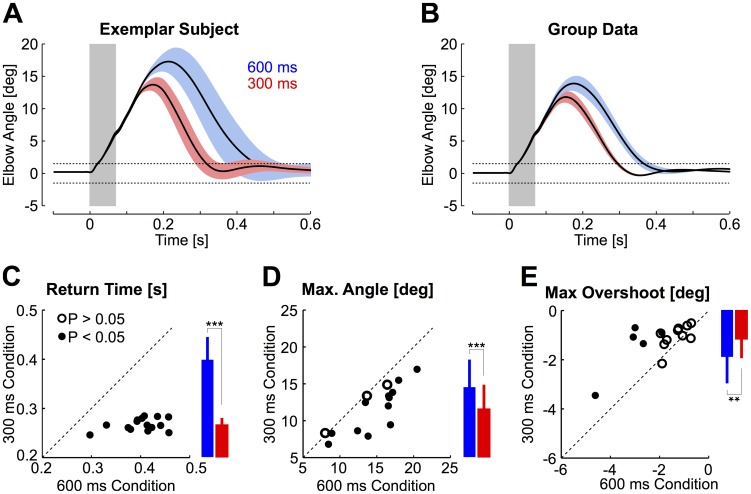
Movement kinematics.A: Average elbow motion from one representative subject. The shaded areas represent 1 standard deviation across trials (blue: 600 ms condition, red: 300 ms condition). The gray rectangle illustrates the duration of the perturbation pulse (70 ms, see Figure 1B). The dashed horizontal lines represent the 3 deg window used to determine the return times and validate the trials offline (see Methods). B: Same as A for group subjects' data. Shaded areas represent 1 standard error across subjects. Panels A and B included all trials. The effect of perturbation offset can be observed as small deviations at the end of the pulse duration (gray rectangle). C: Return times from the 300 ms condition plotted against the return times from the 600 ms condition. Filled dots indicate significant effect across conditions from individual trials (Wilcoxon ranksum test, P<0.05). Data summary in the form of bar plots are presented using the same vertical axis as the scatter plot. Color codes correspond to Panels A and B, and stars indicate significant difference across conditions (3 starts: P<0.001, 2 stars: P<0.01). Vertical bars represent one standard deviation across participants. D: Same as C for the maximum elbow displacement. E: Same as C for the maximum target overshoot. Only successful trials were included in panels C to E.